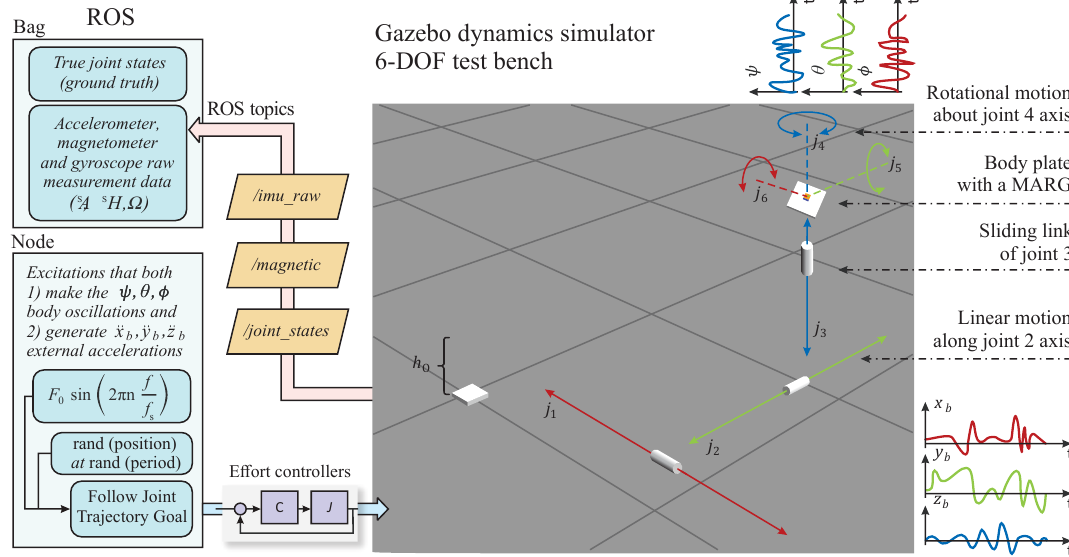
Figure 1. Structure of the test environment in ROS/Gazebo. The 6 DOF test bench consists of three prismatic joints and three revolute joints. The prismatic joints maintain the desired spatial coordinates of the MARG unit. More- over, by sliding back and forth, up, and down the sensor frame in the 3D space different accelerating system conditions are simulated via these joints. The revolute joints control the orientation (instantaneous Euler angles) of the sensor frame. These joints can execute both fast and slow rotation motion to simulate vibration and oscillation effects. A plate is attached to the end of this kinematic chain which contains the MARG unit (see the small orange sensor block in Figure 1). Therefore, this 6 DOF platform enables the control and measurement of the pose of sensor frame; moreover, the implemented sensor models provide the instantaneous measurements (raw sensor data) related to the system dynamics simultaneously. This comprehensive framework supplies the necessary environment and data to both generate various system conditions (dynamic spatial motion, along with exter- nal accelerations and sensor frame vibrations) and access the raw sensor measurements, along with the true system states, for post-processing and analysis. In the first row of Figure 2, three snapshots of the 6 DOF platform are depicted during the motion in the 3D space; moreover, the generated instantaneous accelerometer, gyroscope, and magnetometer measurements are highlighted in the second